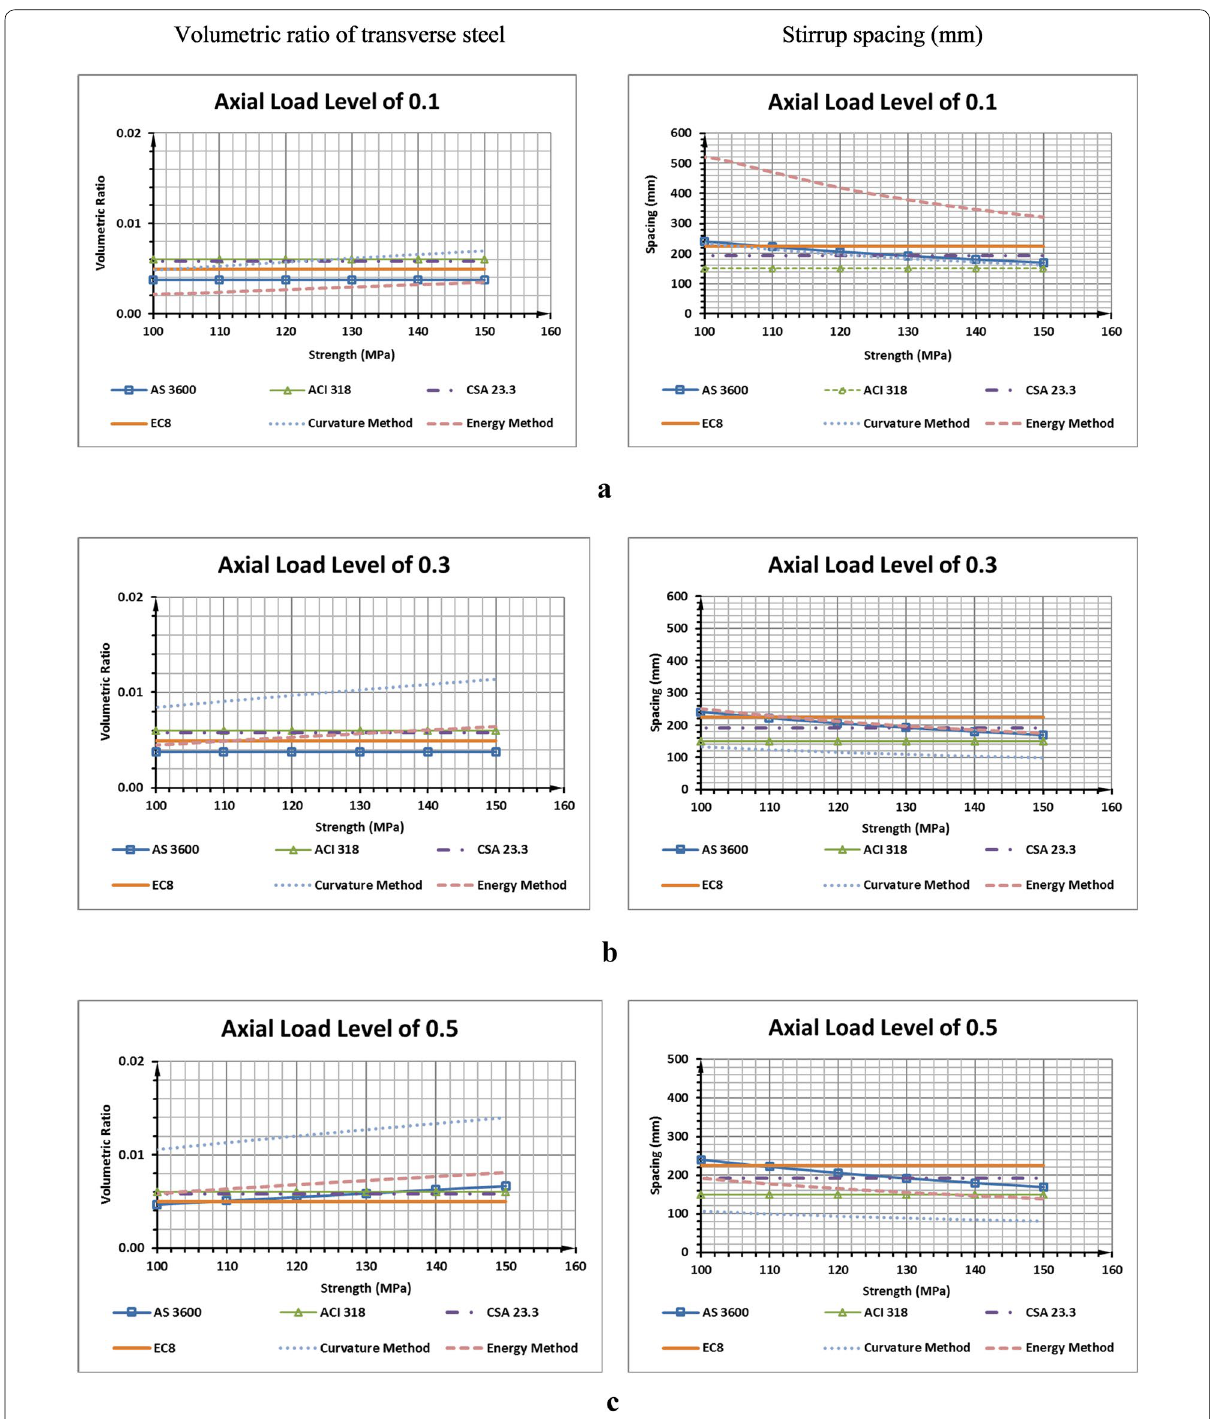
Fig. 14 Required volumetric ratio of transverse steel and stirrup spacing ( ρ sl f co A c 0.3, c P /f co A c =